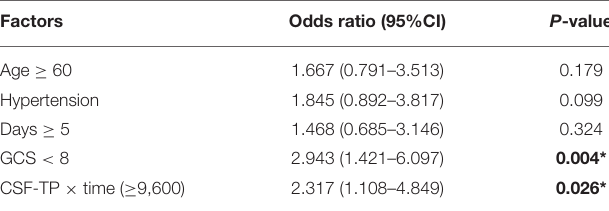
TABLE 3 | Multivariate logistic analysis of the derivation cohort of